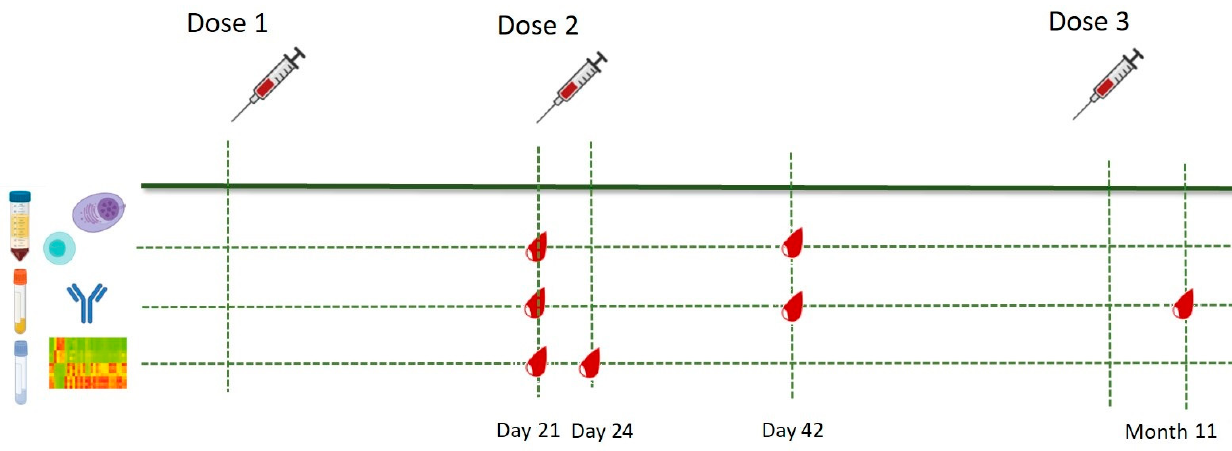
Figure 1. Immunization and sample collection schedule. Eligible participants received two primary doses of the mRNA BNT162b2 vaccine 3 weeks apart and an additional dose 10 months later. Blood samples for T cell phenotyping were collected prior to the second dose (Day 21) and three weeks after the second dose (Day 42). Sera for antibody analysis were collected at the abovementioned time-points, as well as three weeks after the anamnestic dose (Month 11). Blood samples for transcriptome analysis were obtained prior to and three days after the second dose (Day 21 and Day 24, respectively).